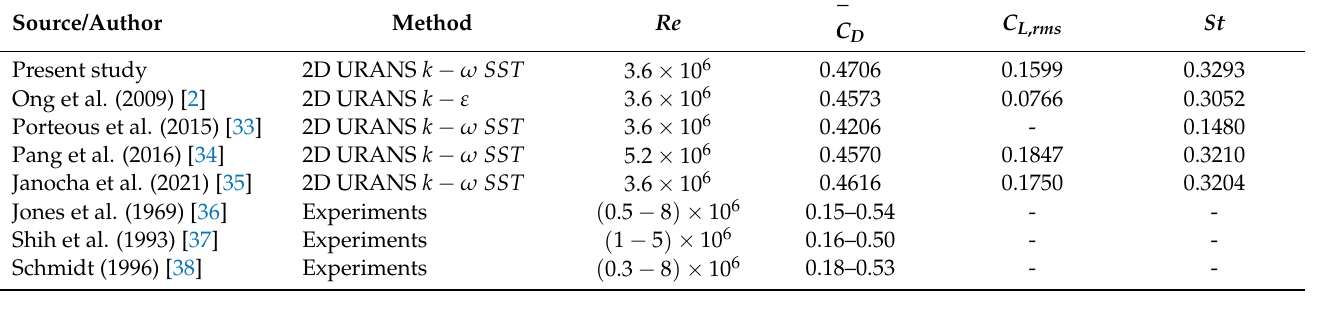
Table 2. Numerical and experimental data of a fixed single cylinder at high Reynolds number regime.